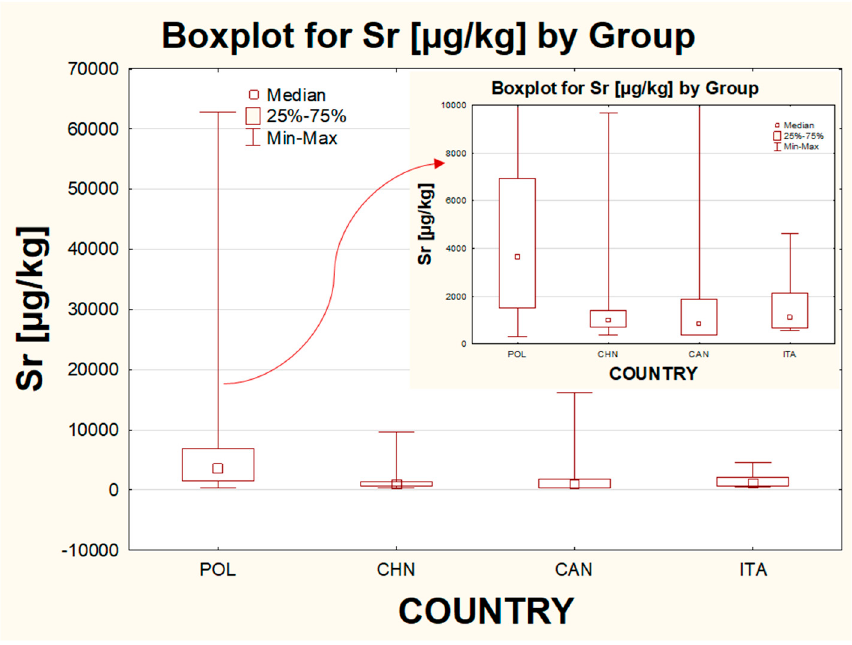
Figure 4. The box–whisker plot representing the influence of the country of origin on the concentration of Sr (µg/kg), where POL—Poland, CHIN—China, CAN—Canada, ITA—Italy.